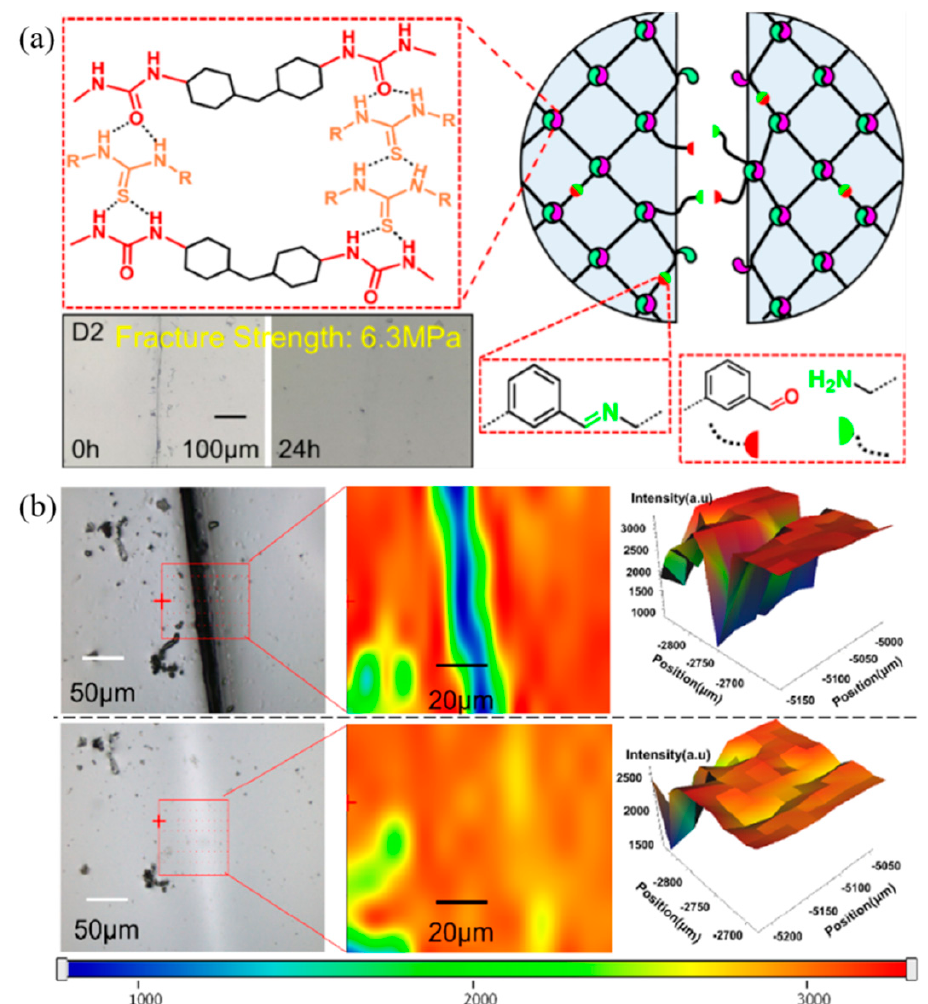
Figure 15. The self-healing model and microscope of silicone elastomers with hydrogen bonding and covalent bonds; ( a ) the model of broken and healing mechanism; and ( b ) the mapping mode of Raman spectra in the healing process [98]. Adapted with permission from [98]. Copyright 2022 American Chemical Society.